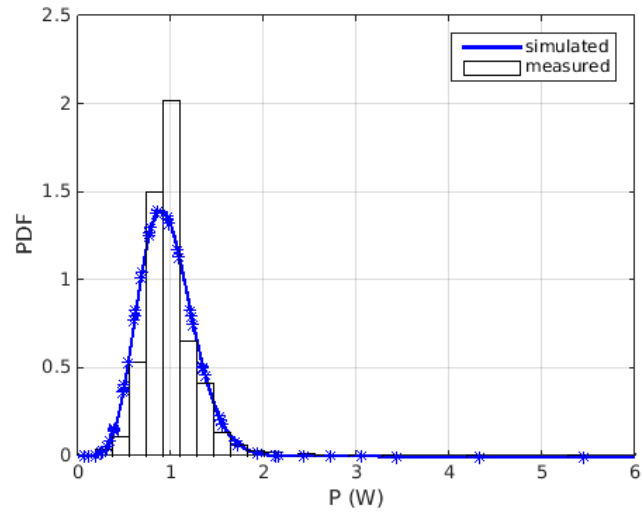
Figure 5. Nakagami-m and Gamma composite